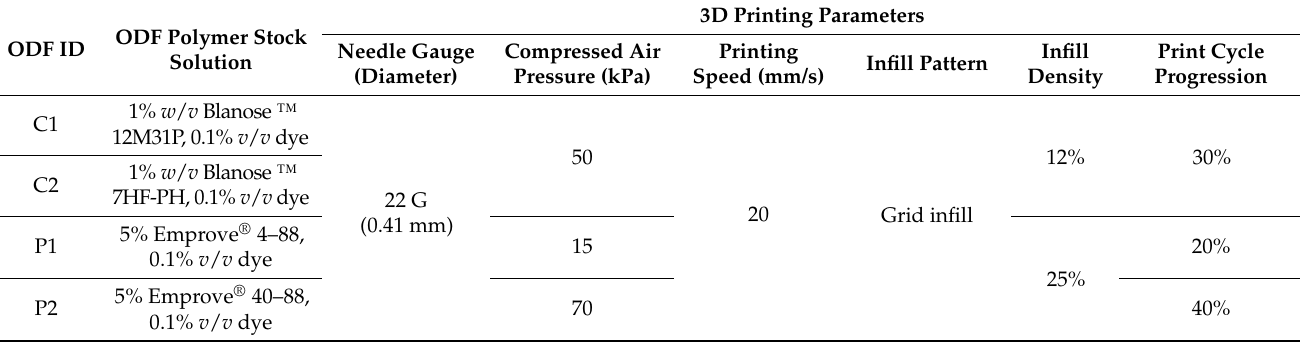
Table 1. ODF polymer formulation solution composition and optimised 3D printing